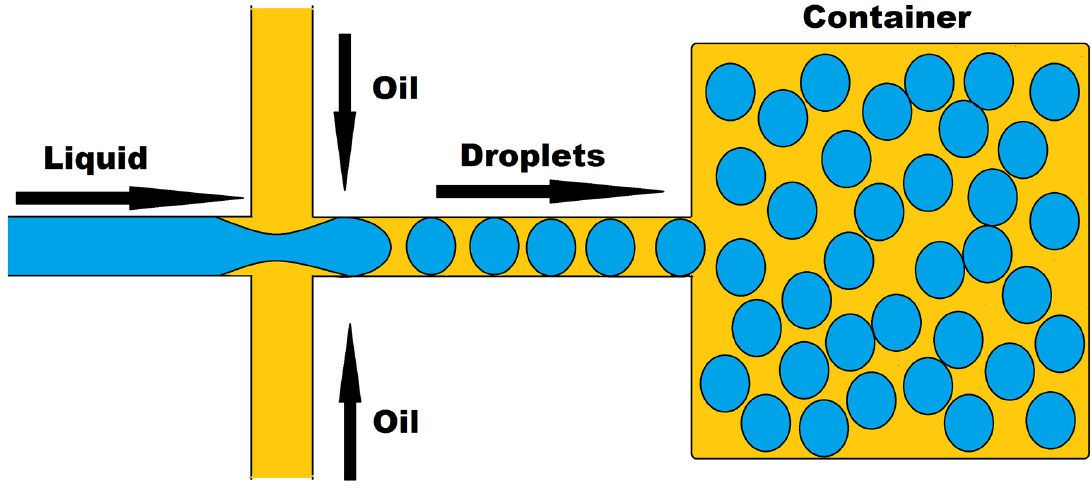
Figure 8. Droplet-based microfluidics.